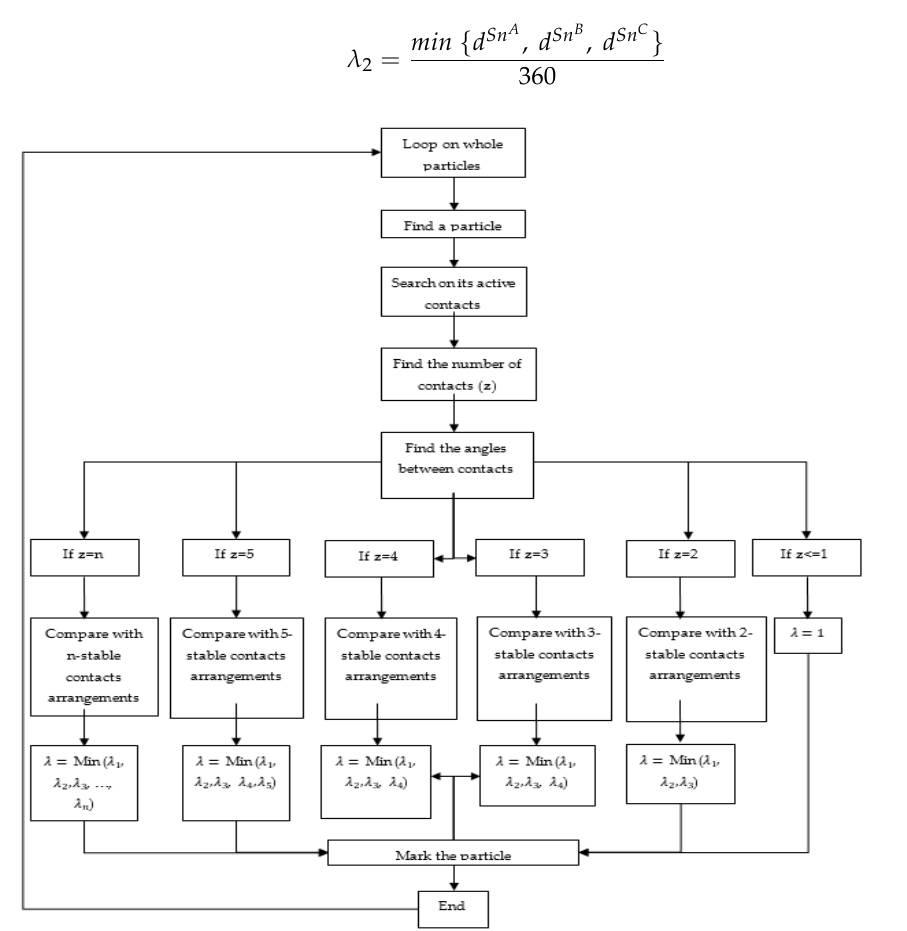
Figure 1. The flowchart of calculating geometrical stability index.